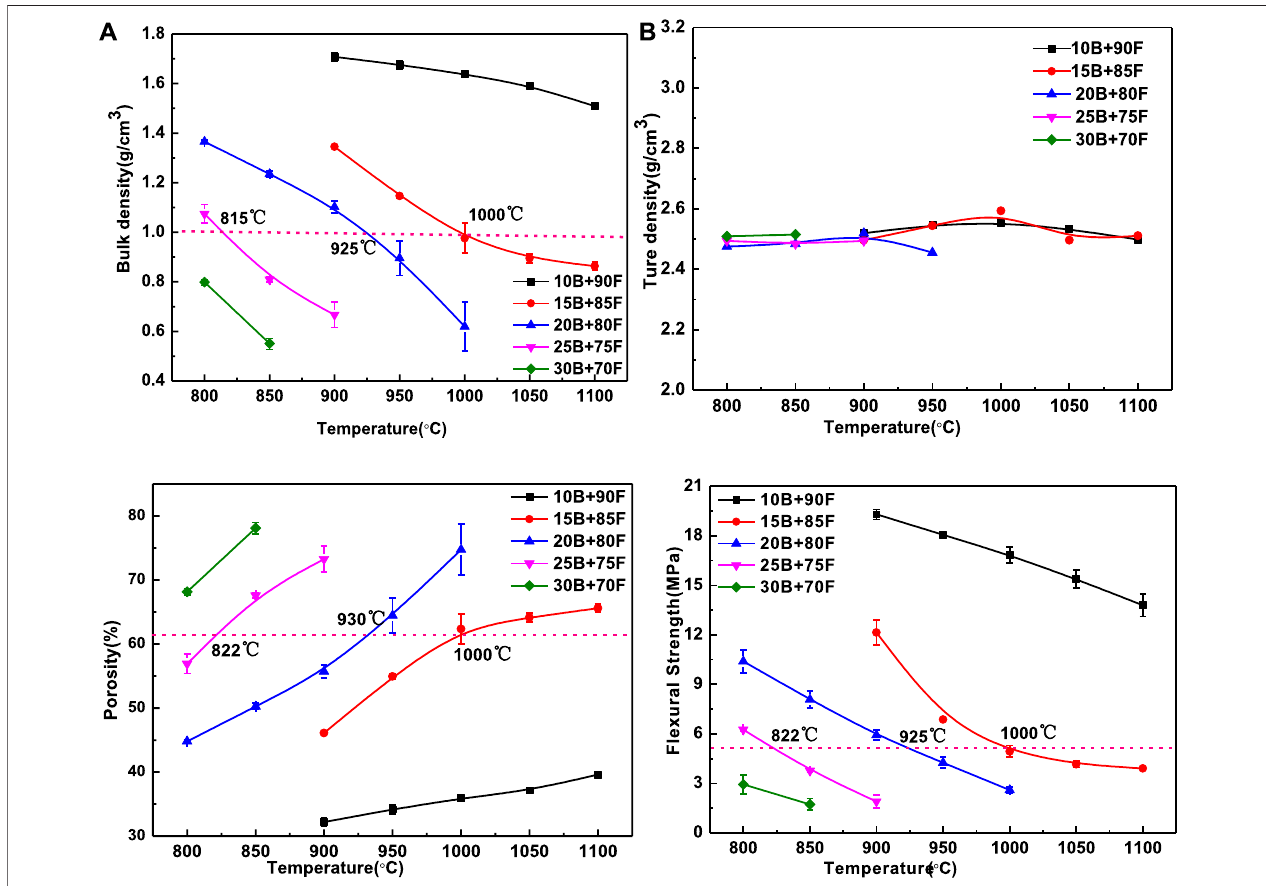
FIGURE 4 | The bulk density (A) true density (B) , porosity (C) and fl exural strength (D) of porous glass-ceramics with different borax additions vary with temperature.